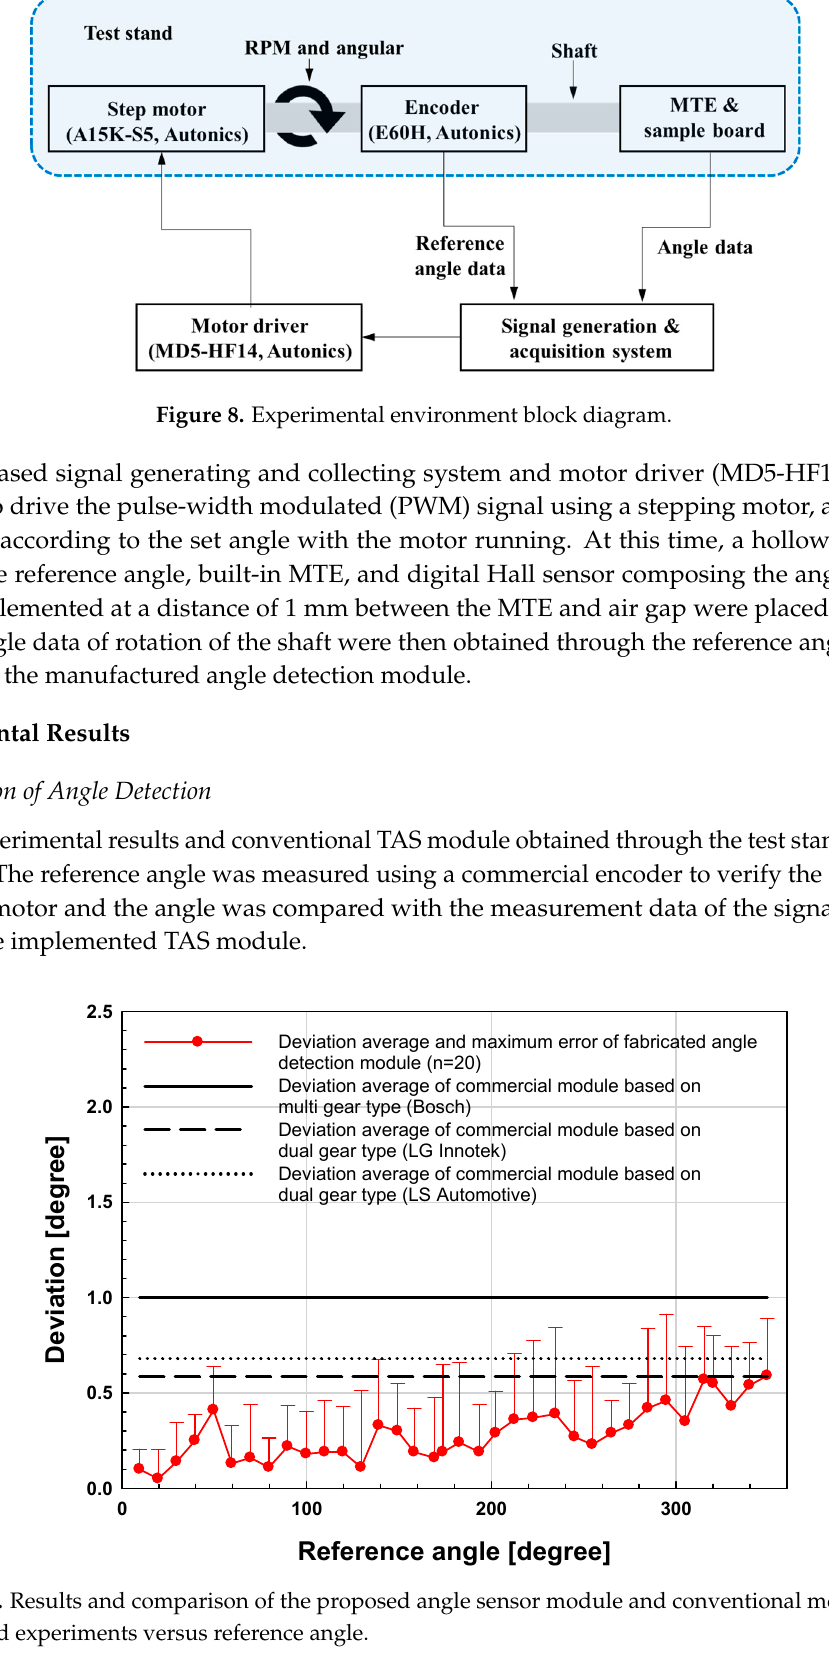
Figure 7. Test stand and experimental setup.